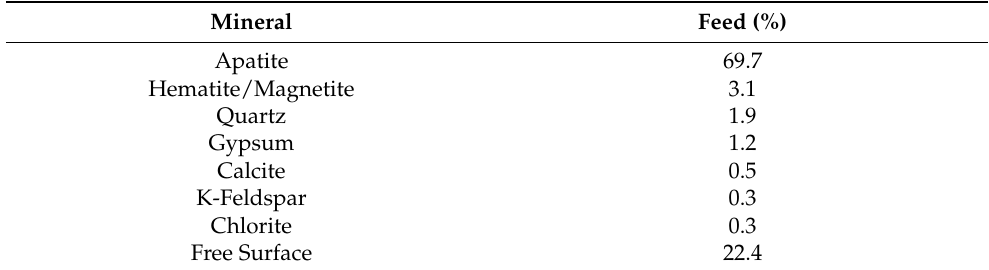
Table 2. Monazite liberation and locking behavior within different minerals in the flotation feed as revealed by TIMA.